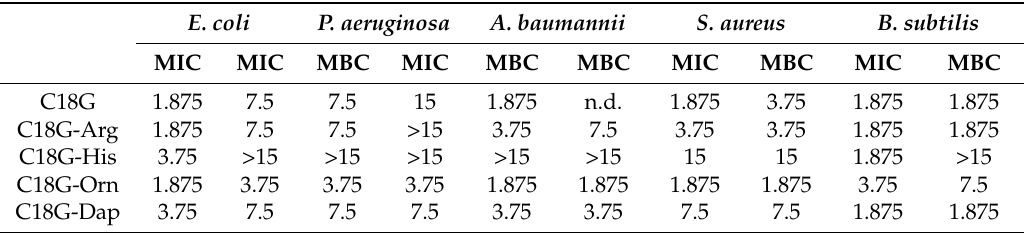
Table 2. Minimum Inhibitory Concentration (MIC) and Minimal Bactericidal Concentration (MBC) ( µ